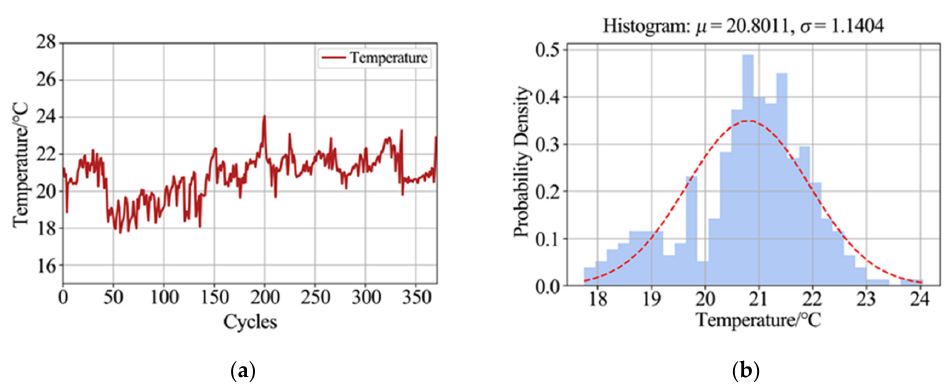
Figure 9. Capacity degradation curves of a series-parallel pack: ( a ) cells; ( b ) pack.